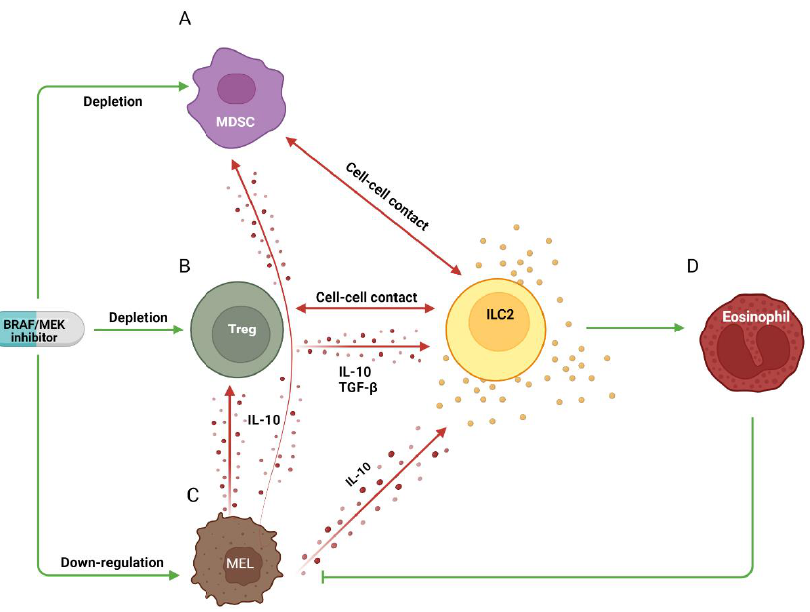
Figure 3. Immunomodulatory properties of BRAF/MEK inhibitors affecting ILC2s. BRAF/MEK inhibitors limit tumor infiltration of MDSCs and Tregs, which may dampen ILC activation through cell–cell contact and suppressive cytokines, such as TGF- β and IL-10 ( A, B ). Moreover, targeted therapy directly down-regulates IL-10 secretion by melanoma cells ( C ). Altogether, these phenomena would contribute to the ILC2-mediated infiltration of anti-melanoma eosinophils ( D